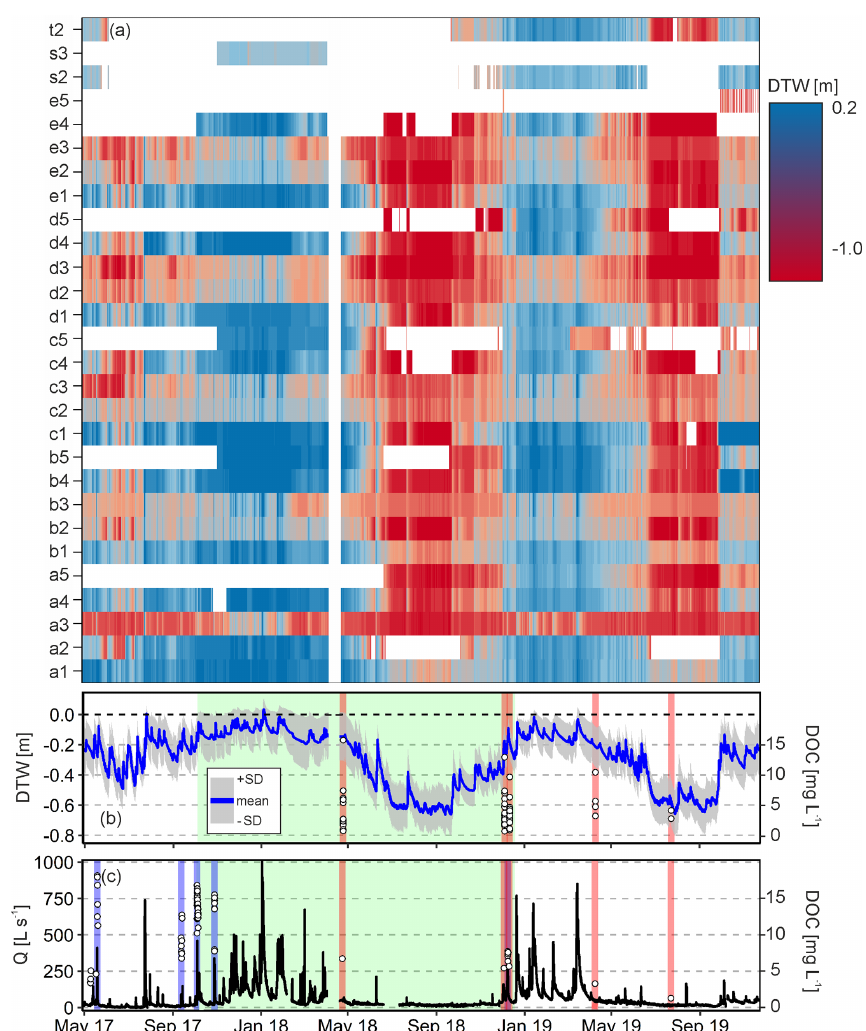
Figure 3. (a) Depth to water table (DTW) time series of all 28 riparian wells. White spaces indicate missing data in the time series: due to varying (de)installation times (if white in the beginning), sensor failure (white gaps in every time series) and dryness-induced disconnection of wells with the groundwater (white gaps in red areas). Locations of wells are depicted in Fig. 2. (b) Time series of mean DTW values (blue line) ± the standard deviation (grey ribbon). A positive value of DTW indicates water ponding at the soil surface or that the piezometer measured a locally confined part of the aquifer. Red vertical bars indicate sampling dates of riparian groundwater. Points within the red bars show DOC concentration of respective riparian samples. Green area indicates the modeling period where ground water levels were used for calibration. (c) Discharge time series of the central pressure transducer. Blue vertical bars indicate stream water autosampler dates during events; red vertical bars indicate grab sampling dates of stream water. Points within blue and red bars show DOC concentrations according to stream water samples. Green area indicates the modeling period where ground water levels were used for calibration. Note that the flood event at the beginning of January 2018 is